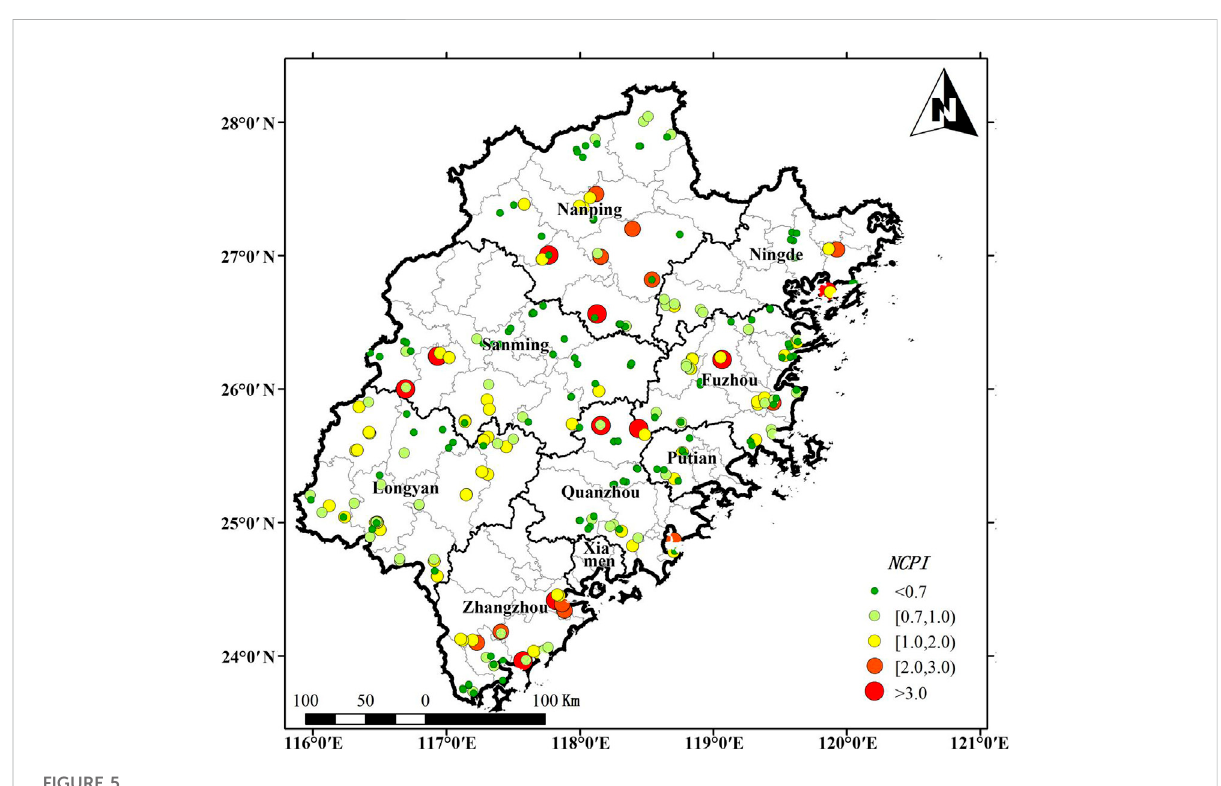
FIGURE 5 Distribution of comprehensive pollution index of heavy metals in